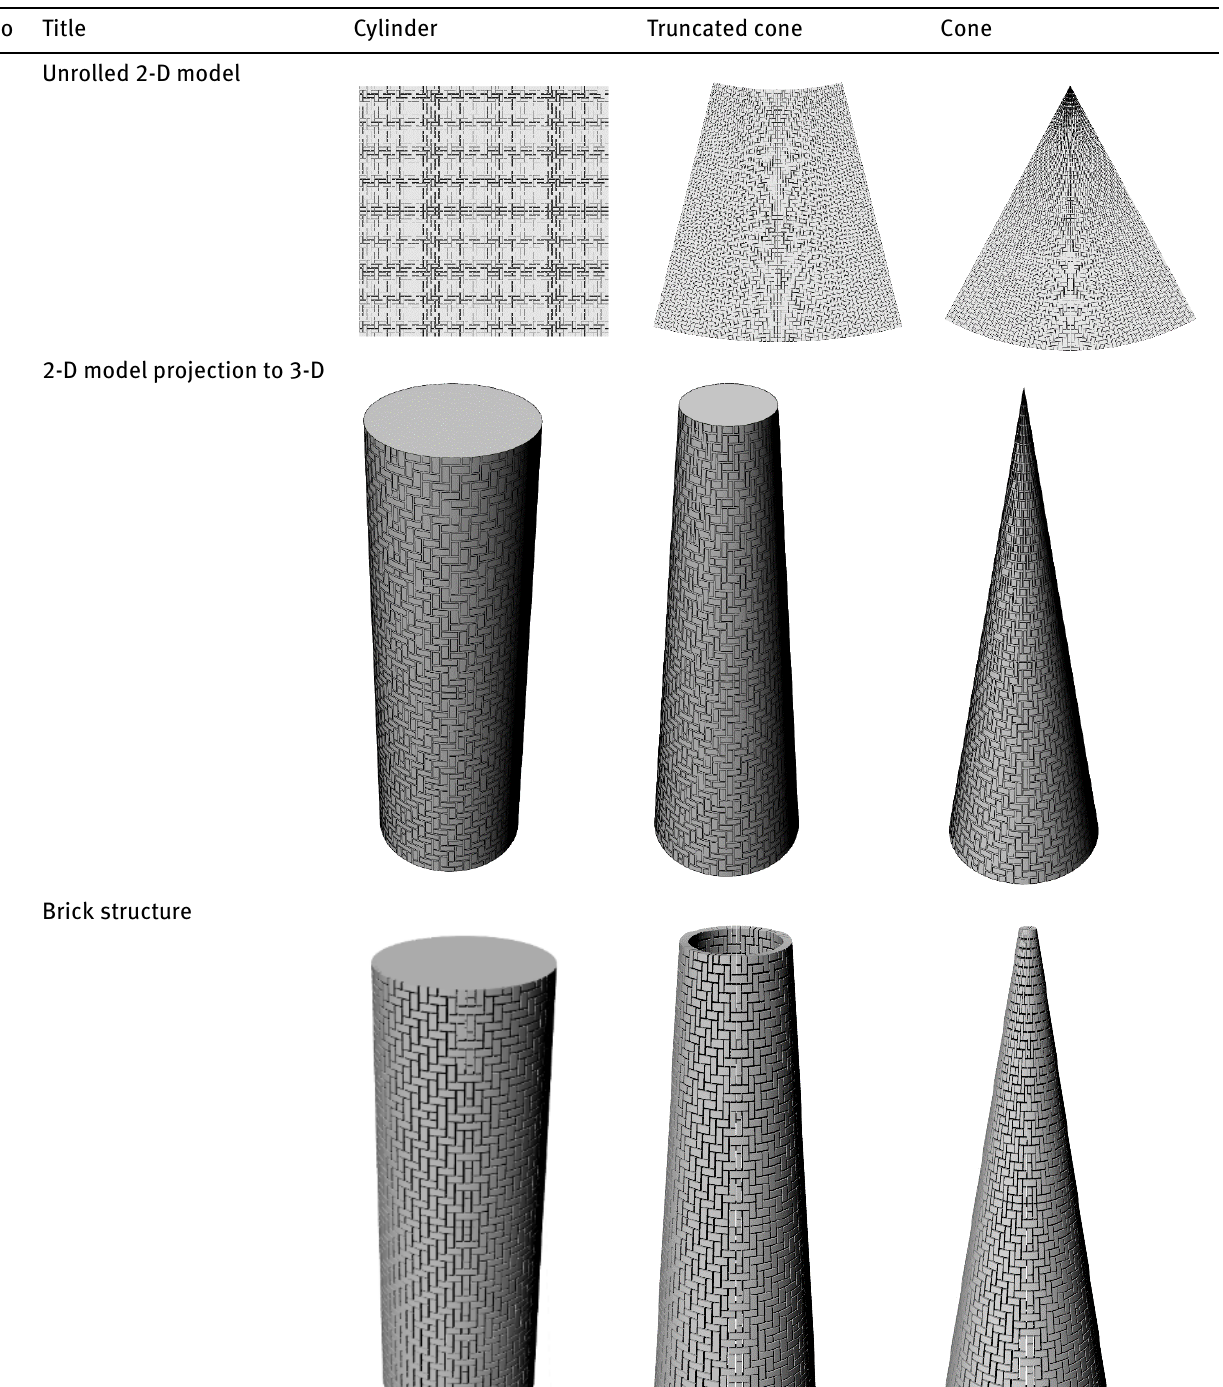
Table 2: The change process in 90-degree herringbone brickwork pattern modeled on different 3-D shapes (cylinder, truncated cone, and